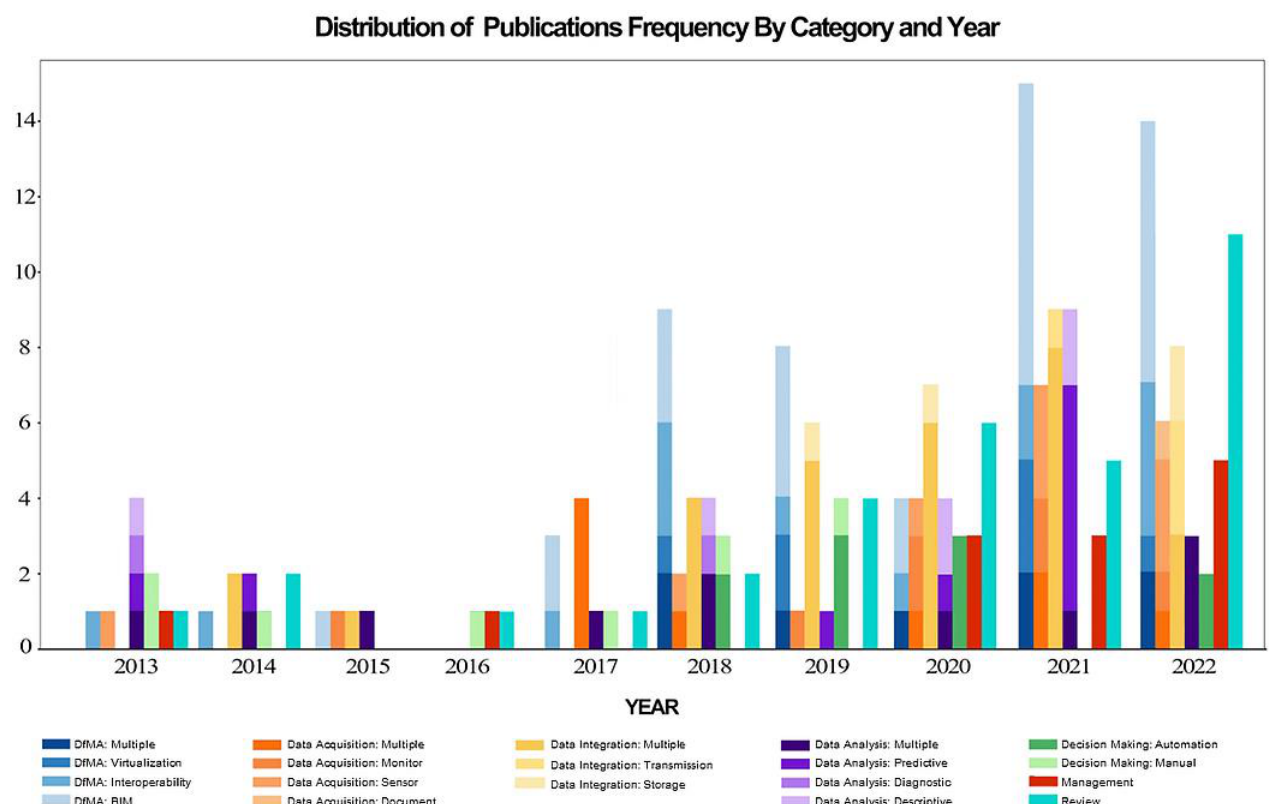
Figure 6. Distribution of publication frequency by category (subcategory) and year.